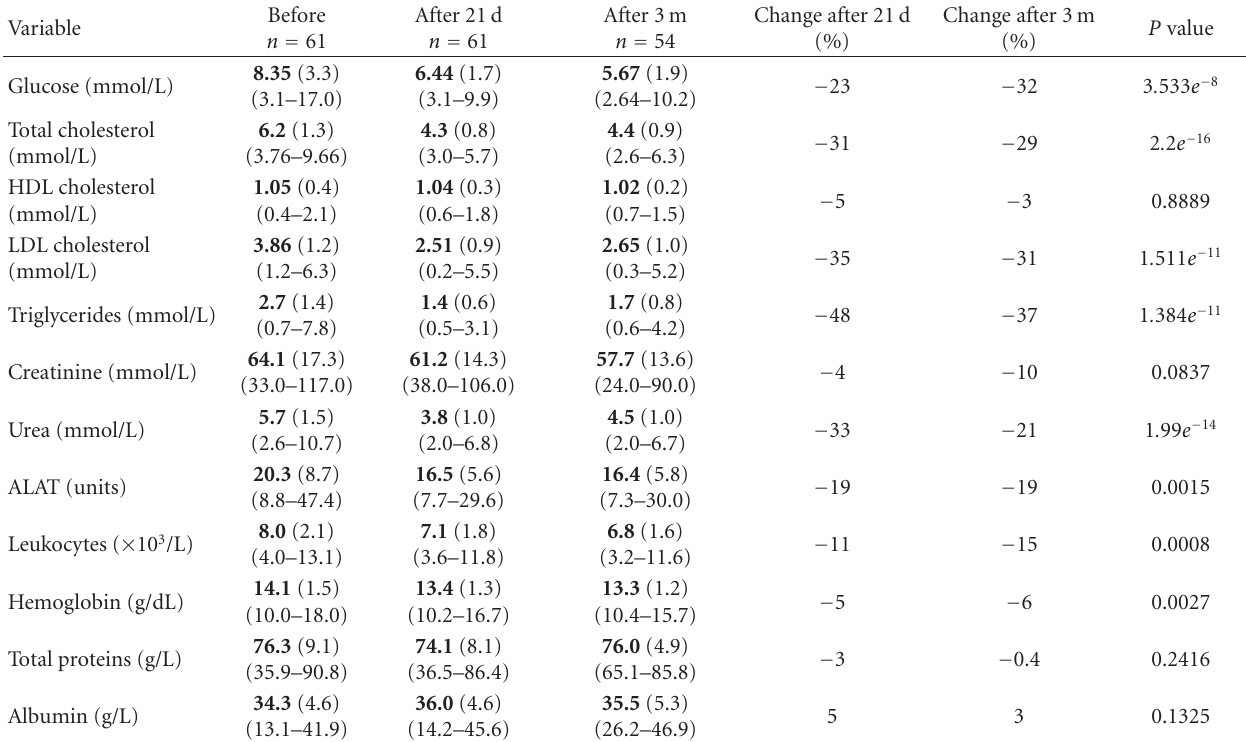
Table 3: Changes of serum biochemical indicators during 3-month intervention with Ma-Pi 2 macrobiotic diet in type 2 diabetic adults.